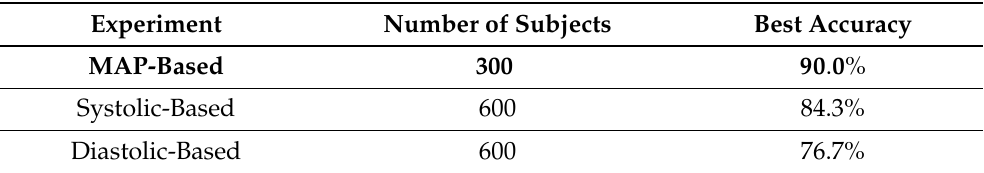
Table 16. SVM classifier results for systolic-based, diastolic-based, and MAP-based experiments (original + synthetic